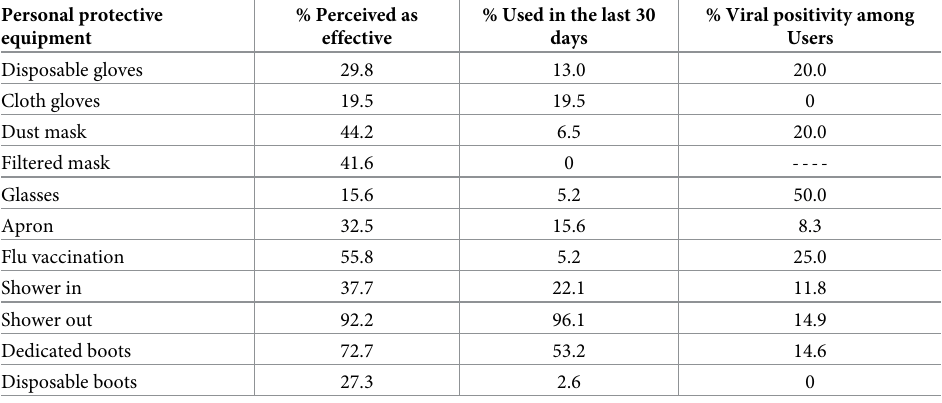
Table 5. Perceptions of efficacy of personal protective equipment (PPE) at preventing cross-species infection, reported use, and viral positivity among PPE users in 77 worker nasal wash samples collected from farms, abat- toirs, and live animal markets in Sarawak, Malaysia in June and July of 2017. Viral positivity is defined as a positive rPCR or rRT-PCR result for at least one of the following viruses: adenovirus, coronavirus, enterovirus, encephalomyo- carditis virus, influenza A-D, porcine circovirus 2, or porcine rotavirus